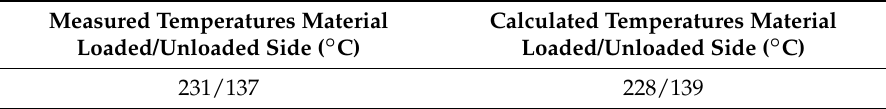
Figure 16. Temperature distribution in the inner ring. On the LHS the temperature distribution on the surface of the inner ring is shown. On the RHS the temperature distributions in the two planes are shown where thermocouples were placed. Table 3. Comparison between the measured and the calculated temperatures for the Inner ring at the operating conditions mentioned